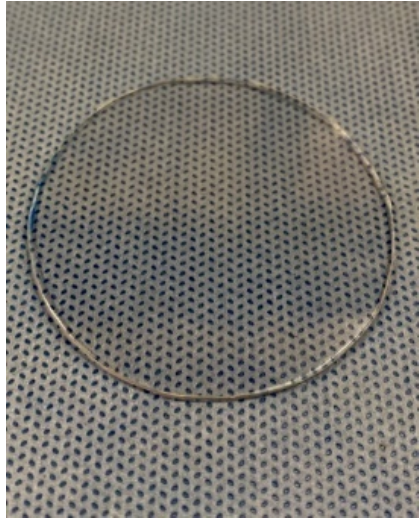
Figure 3. Circular specimen with a 50 mm diameter.